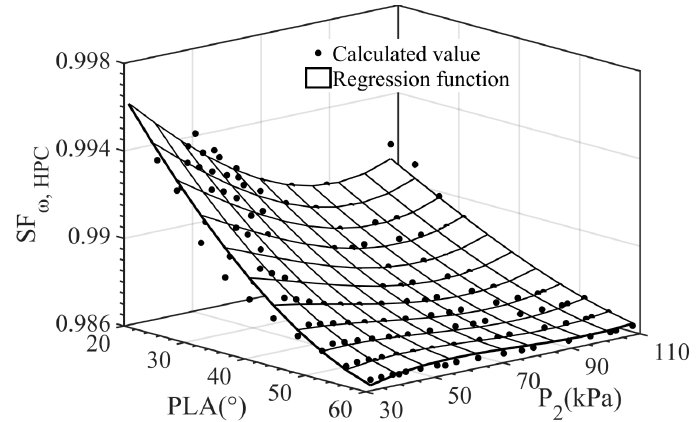
Figure 10. Regression analysis result of the mapping relationship: Case 4.